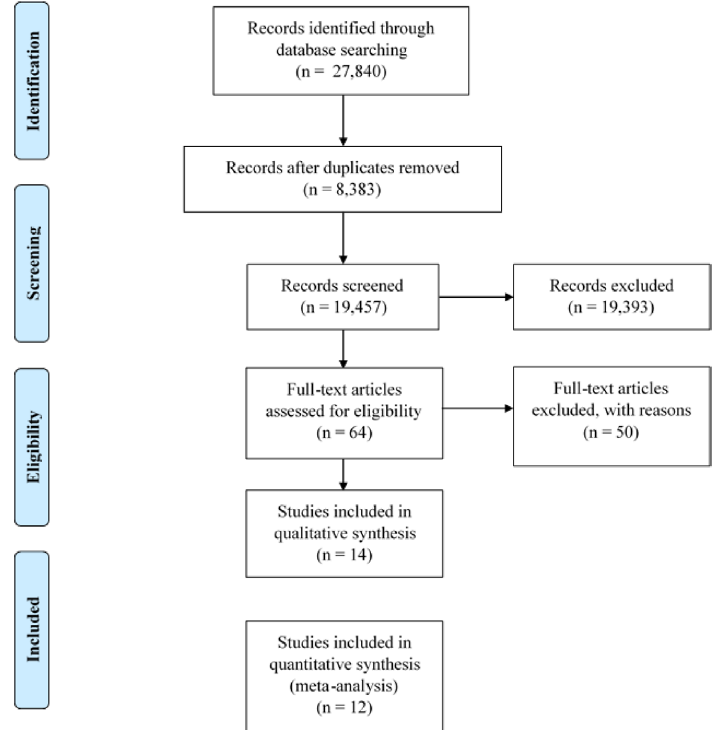
Figure 1 - The flow of studies through the review. n, sample